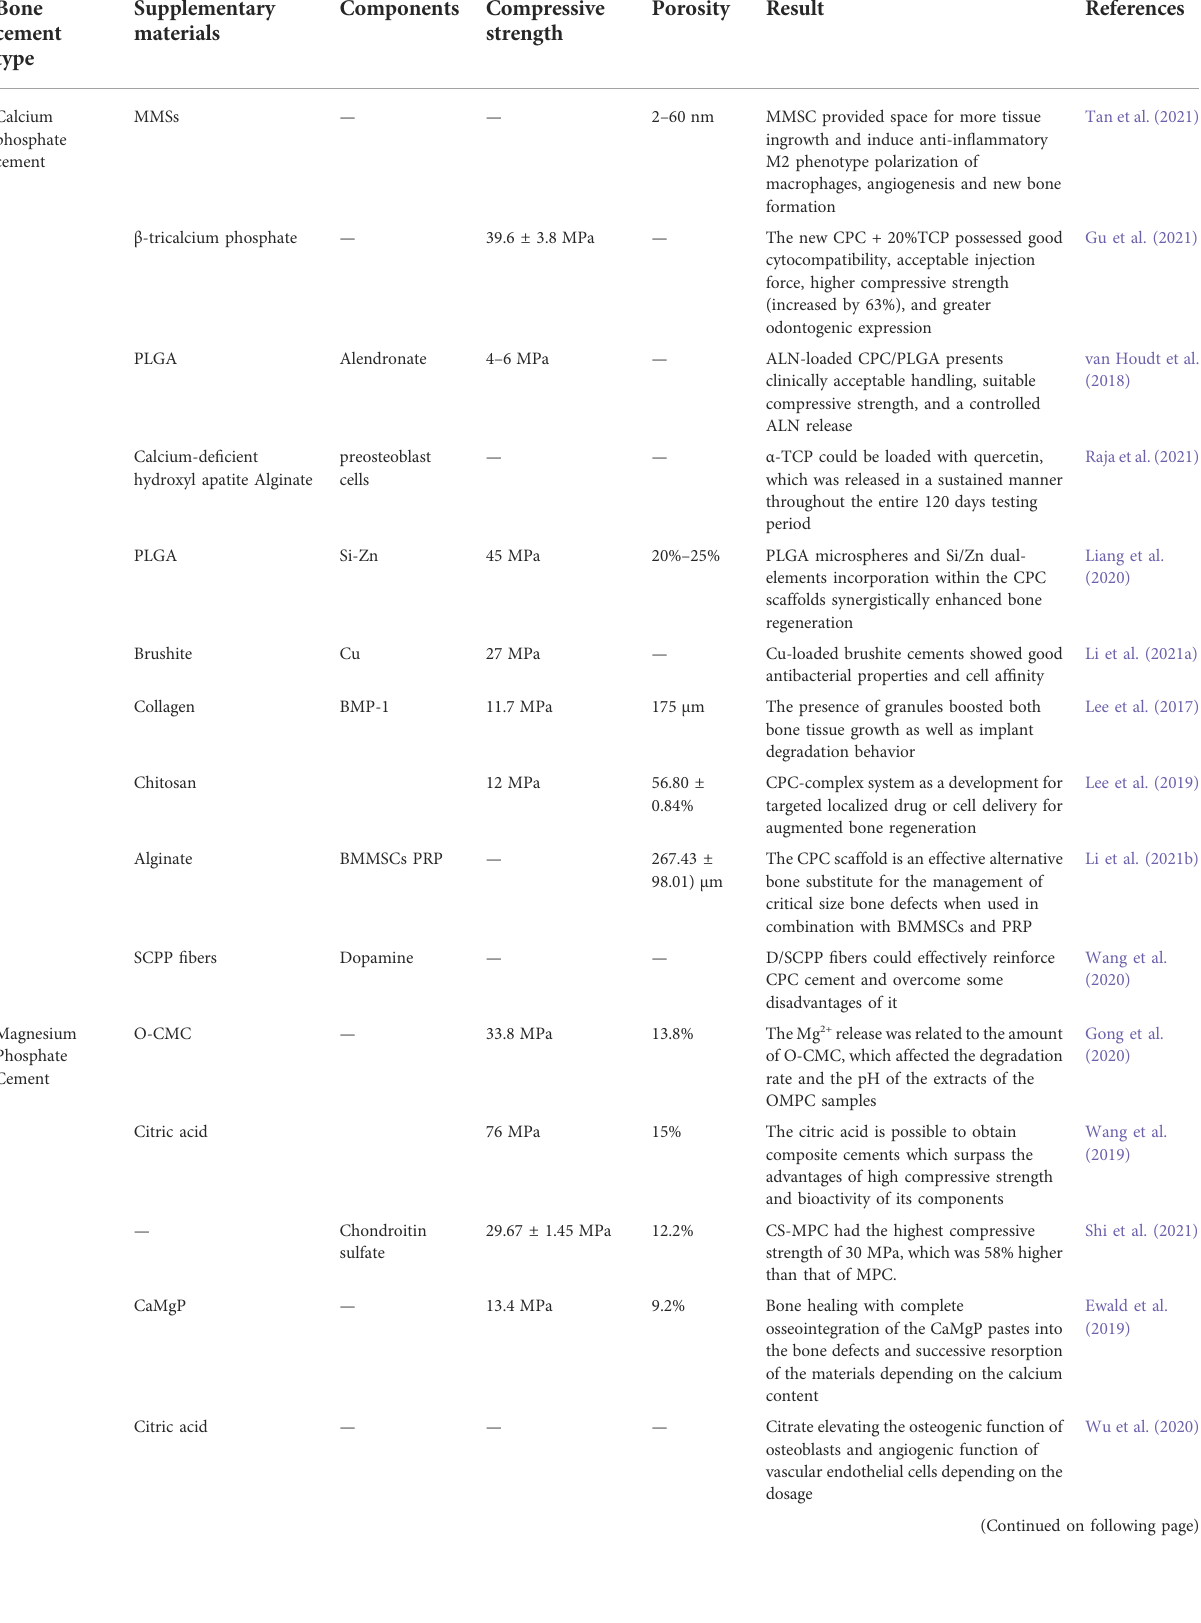
TABLE 2 Improve bone cement to promote bone defect